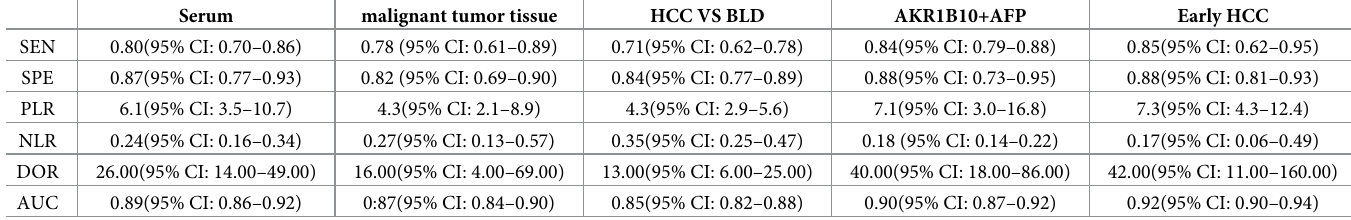
Table 2. Summary of subgroup